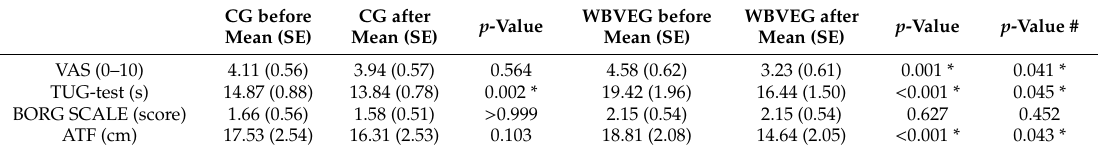
Table 2. Pain level, functionality (TUG test and anterior trunk flexion (ATF)), and subjectively perceived exertion rating (BORG Scale CR-10) assessments before and after the intervention and between groups. CG before Mean